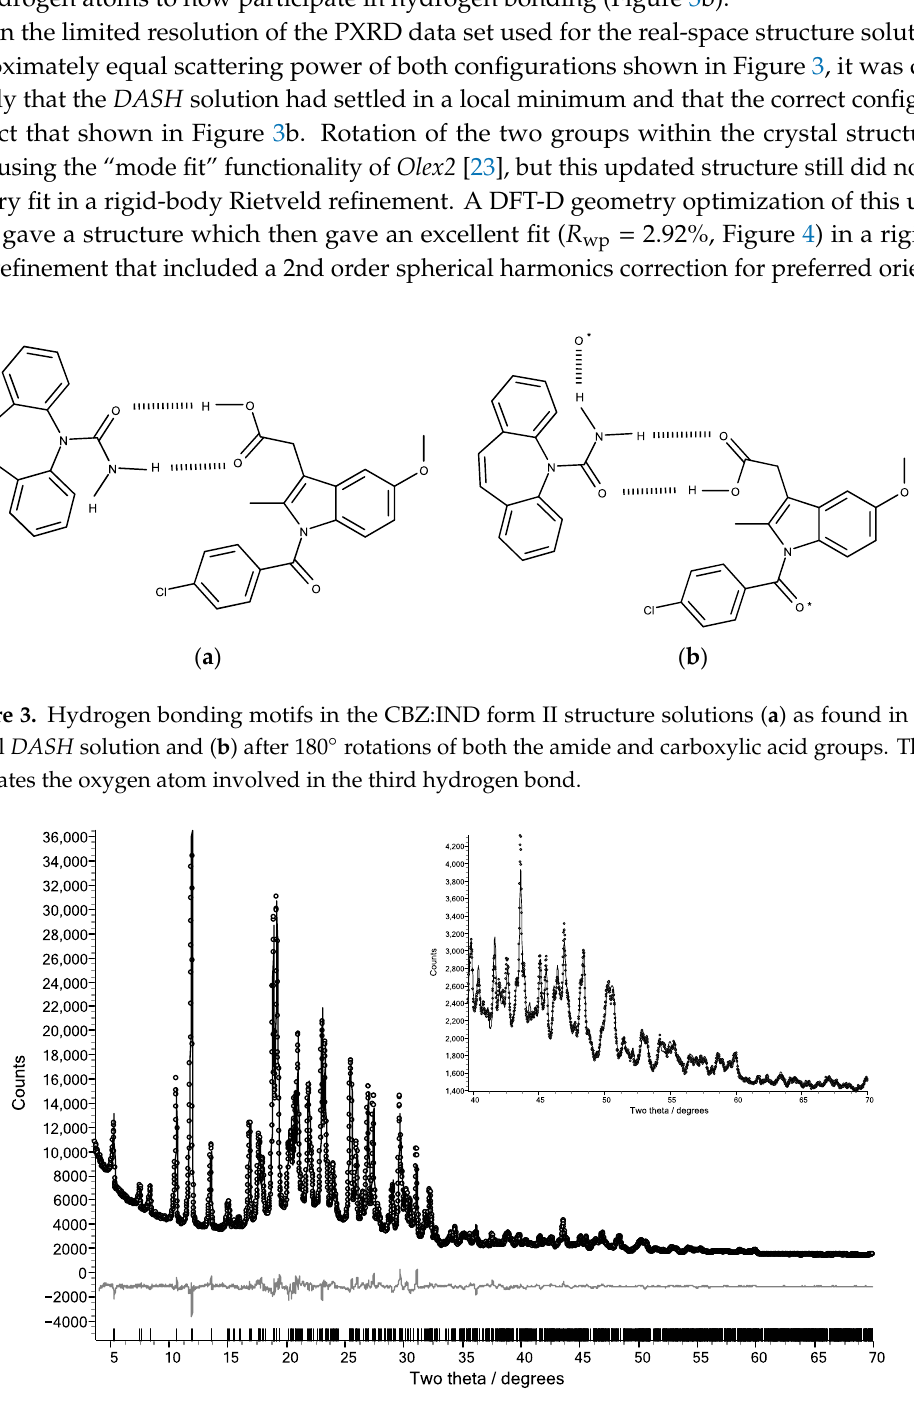
Figure 4. Observed (open circles) and calculated (solid black line) data for the Rietveld refined crystal structure of CBZ:IND form II. The difference plot is shown in grey, reflection positions are indicated by vertical markers on the x-axis, and the inset shows the fit to the data at a high angle. A variable-cell DFT-D optimization of this final rigid-body refined structure resulted in only a small root mean square deviation (0.064 Å). The examination of the final refined structure (Figure 5) showed some significant changes in the core geometry of the indomethacin molecule, distinct from the purely conformational changes that result from torsion angle optimization in DASH and TOPAS . Of particular note is a change in the geometry of the chlorobenzyl group, with (a) a bond angle N1– C9–C10 opening from 116.80 ° (as seen in INDMET03) to 120.06 ° and (b) the disposition of Cl1 and C9 relative to the mean plane of the C10–C11–C12–C13–C14–C15 ring being altered (see Table 4).